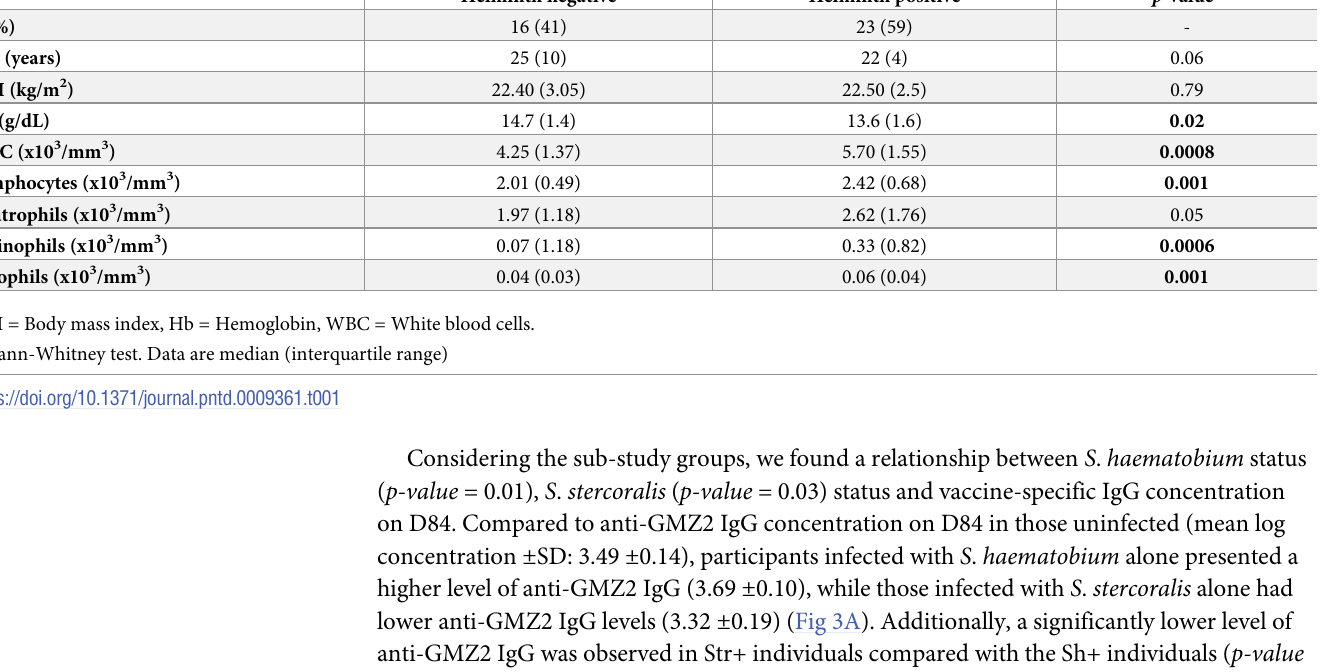
Table 1. Characteristics and hematological profile of the study population on D84 with regard to helminth status.